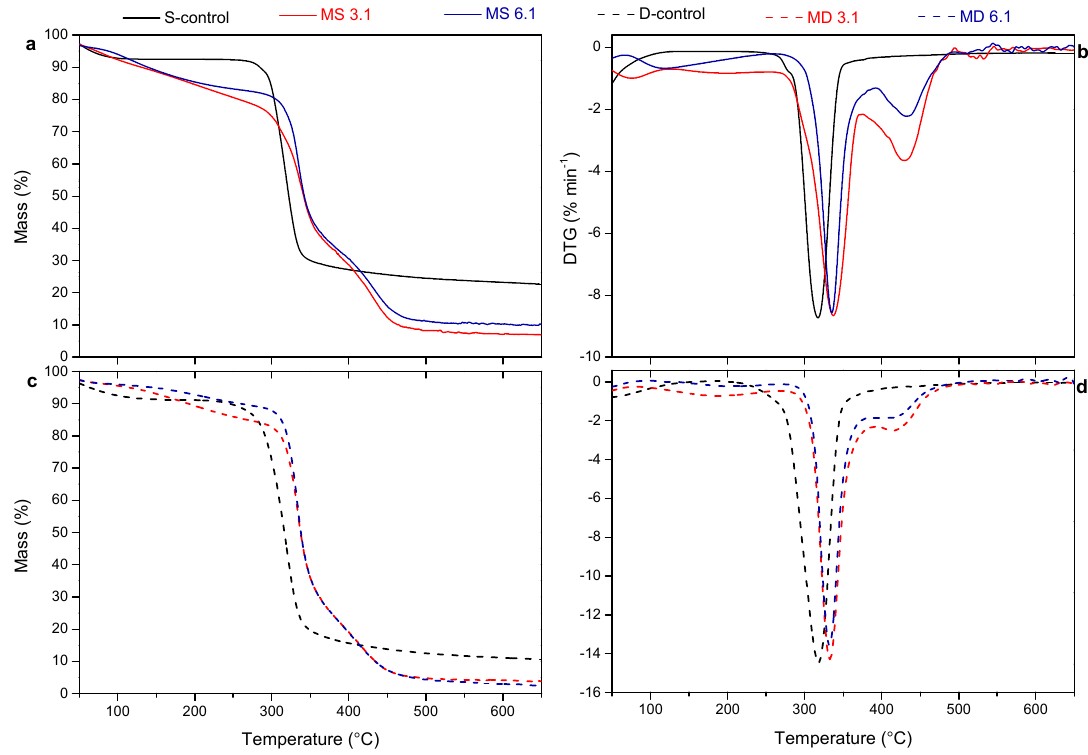
Figure 3. Mass loss and first derivative (DTG) of S-control, MS 3.1 and MS 6.1 ( a , b ) and D-control, MD 3.1 and MD 6.1 ( c , d ). Table 2. Thermal degradation properties of unmodified and modified starch and dextrin (°C).